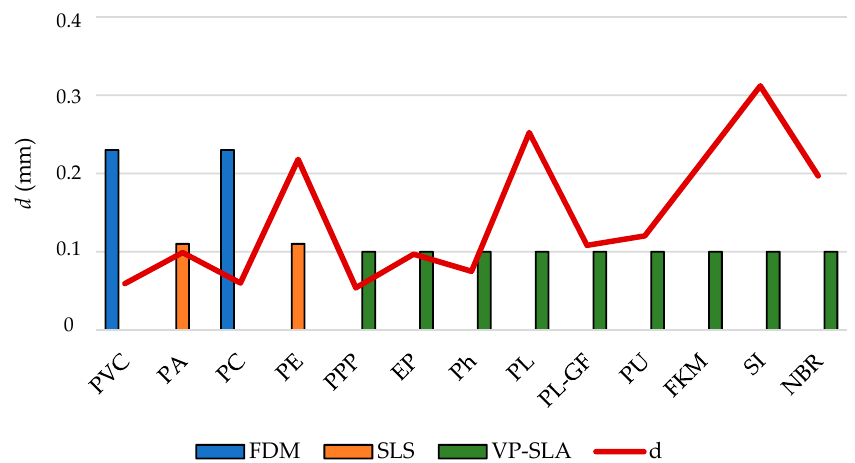
Figure 8. Heat penetration depth ( d ) versus expected layer thickness ( t layer,min ) for the considered candidate AM techniques.